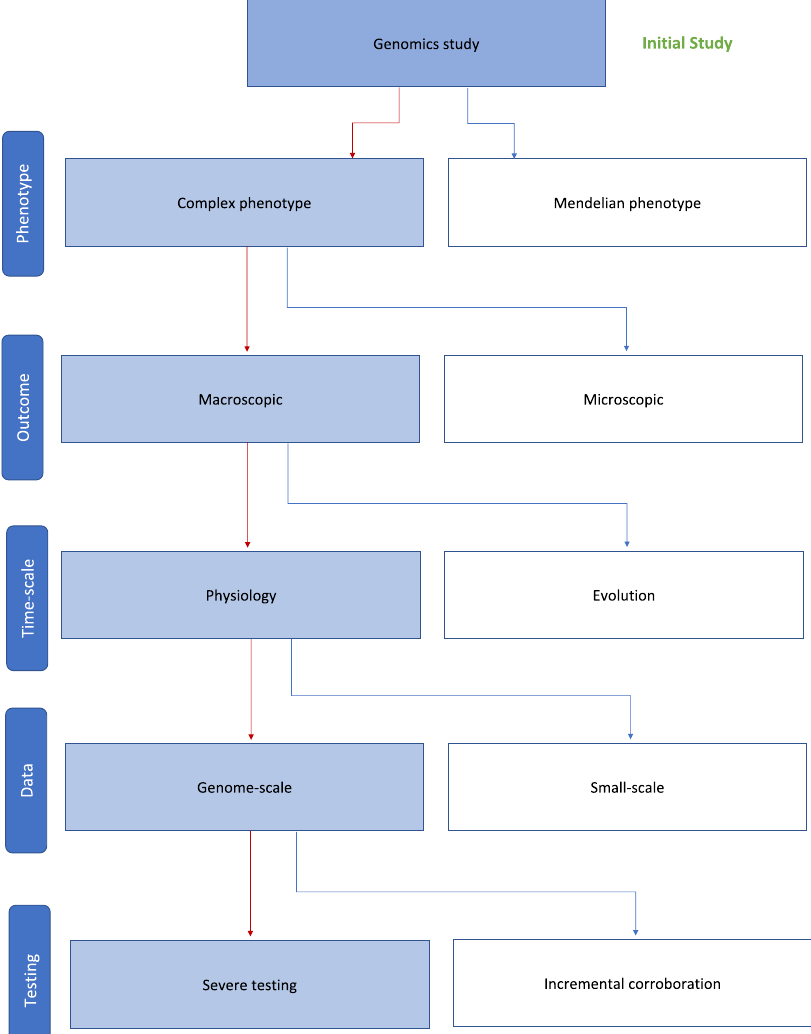
Fig. 3 Classi fi cation of omics studies to identify prime candidates for severe testing. Each layer performs a decision based on the criterion shown on the left (phenotype, outcome, time scale, data, and